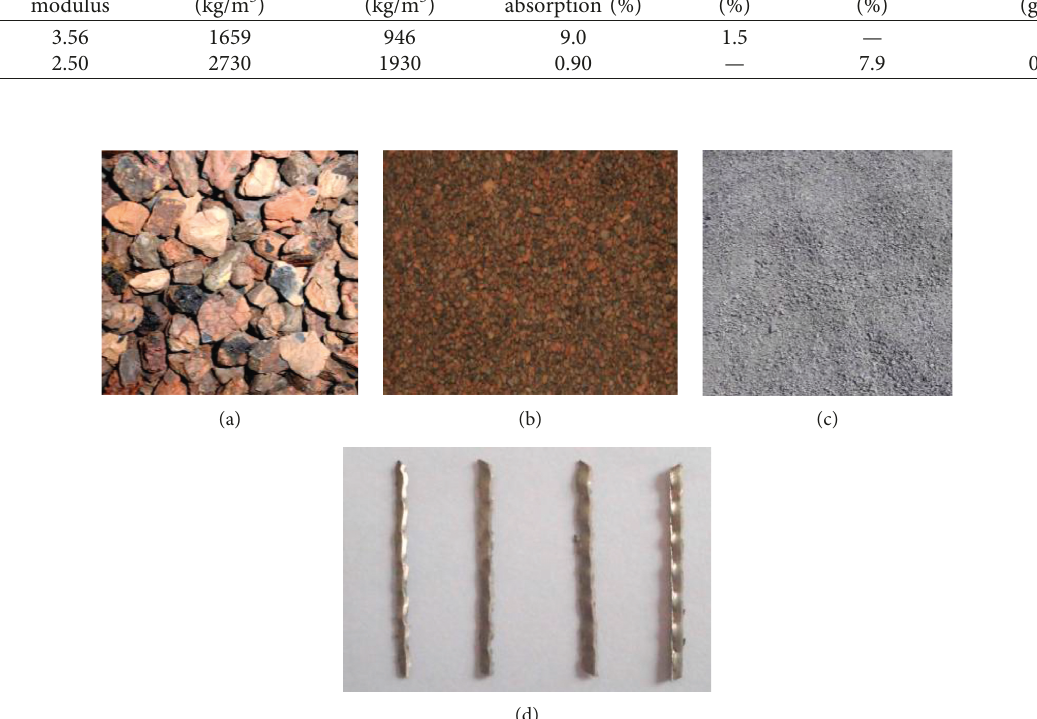
Figure 1: Morphology features of aggregates and steel fibers. (a) Expanded shale; (b) lightweight sand; (c) manufactured sand; (d) steel